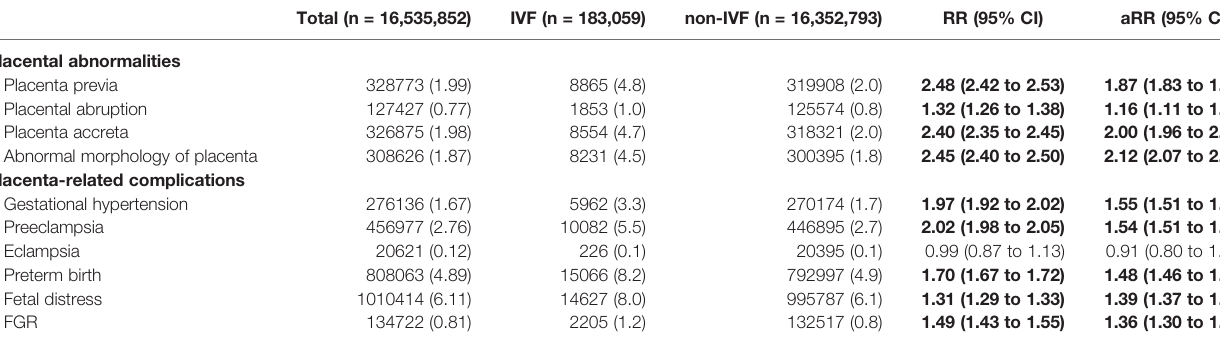
IVF, in vitro fertilization; Non-IVF, non-in vitro fertilization; FGR, fetal growth restriction. RR, relative risk; aRR, adjusted relative risk. CI, con fi dence interval. RR were calculated in Poisson regression modelling with restricted cubic splines of exact maternal age. aRR were calculated in Poisson regression modelling with restricted cubic splines of exact maternal age, with adjustment for geographic region, maternal age, year, ethnicity, and chronic diseases before pregnancy. The bold values means has statistically signi fi